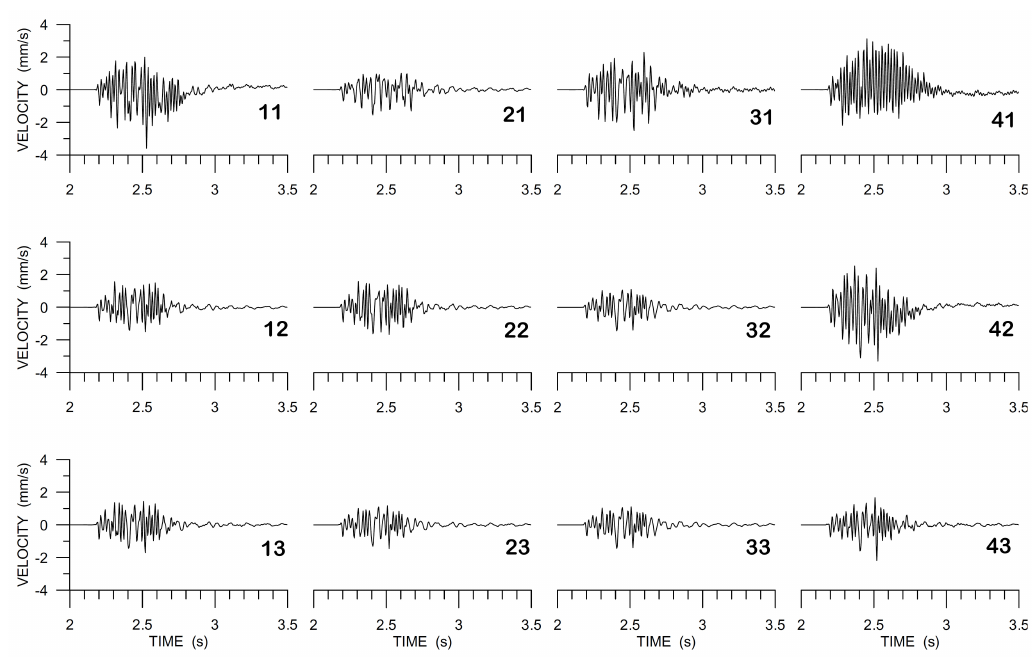
Figure 10. Array raw data (LE-3DLite), E-component. The arrangement of the seismograms corresponds to the array arrangement in Figure 2. Two-digit numbers are used to code the individual stations.